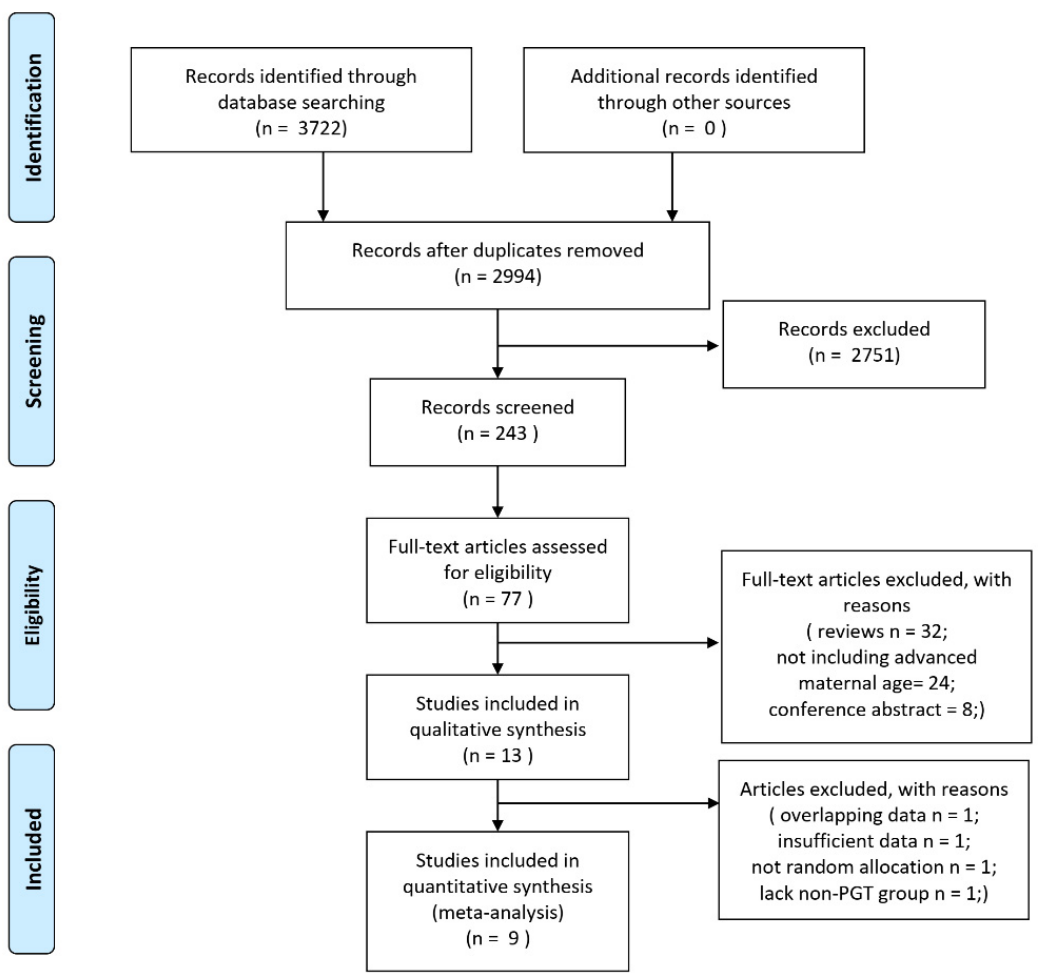
Figure 1. PRISMA flow chart of selection process for meta-analysis.